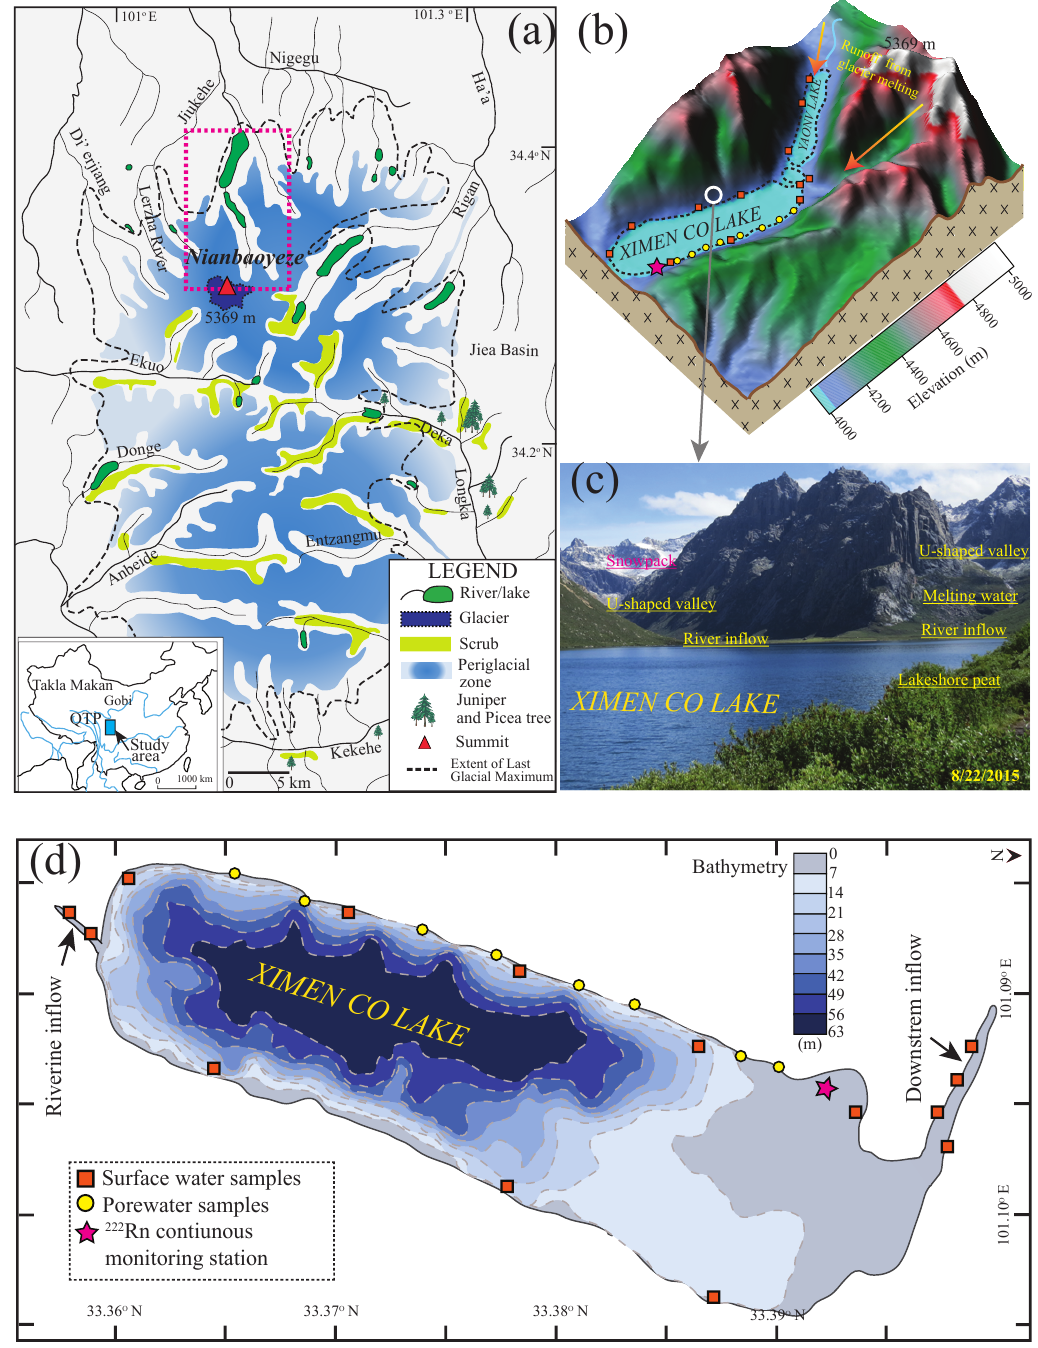
Figure 1. The geological and topographic map of the Yellow River source region, Nianbaoyeze glacial mountains (a) , and sampling settings of Ximen Co Lake (b) , with the bathymetry map of the lake (d) . (c) Photograph of Ximen Co Lake and the surrounding geomorphic settings looking in a northeasterly direction on 22 August 2015, showing the late-laying snowpack in the U-shaped valleys of the northern part of the Nianbaoyeze